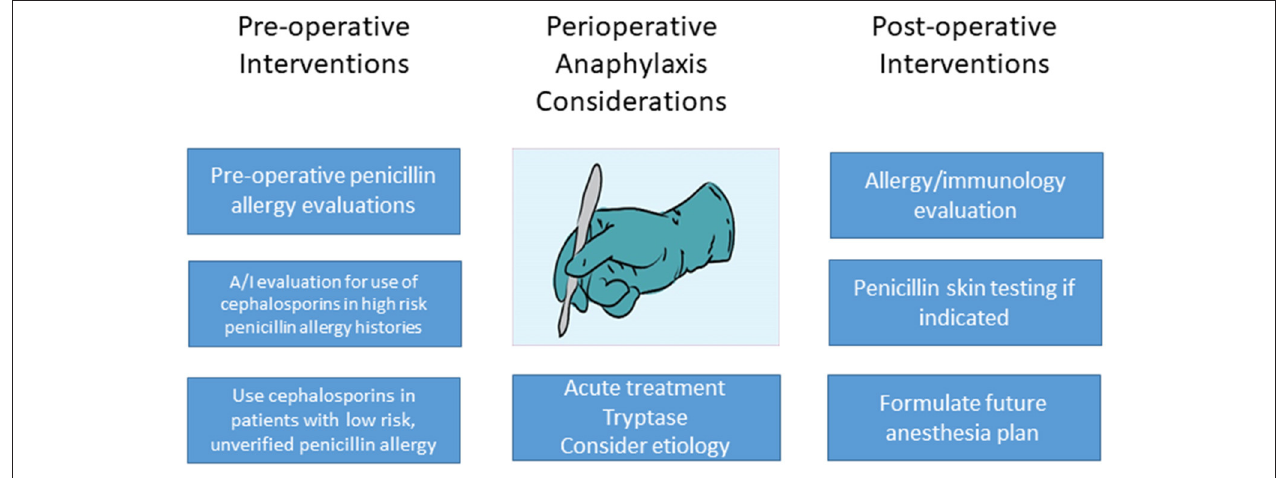
FIGURE 1 | Areas to intervene with penicillin allergy and the perioperative